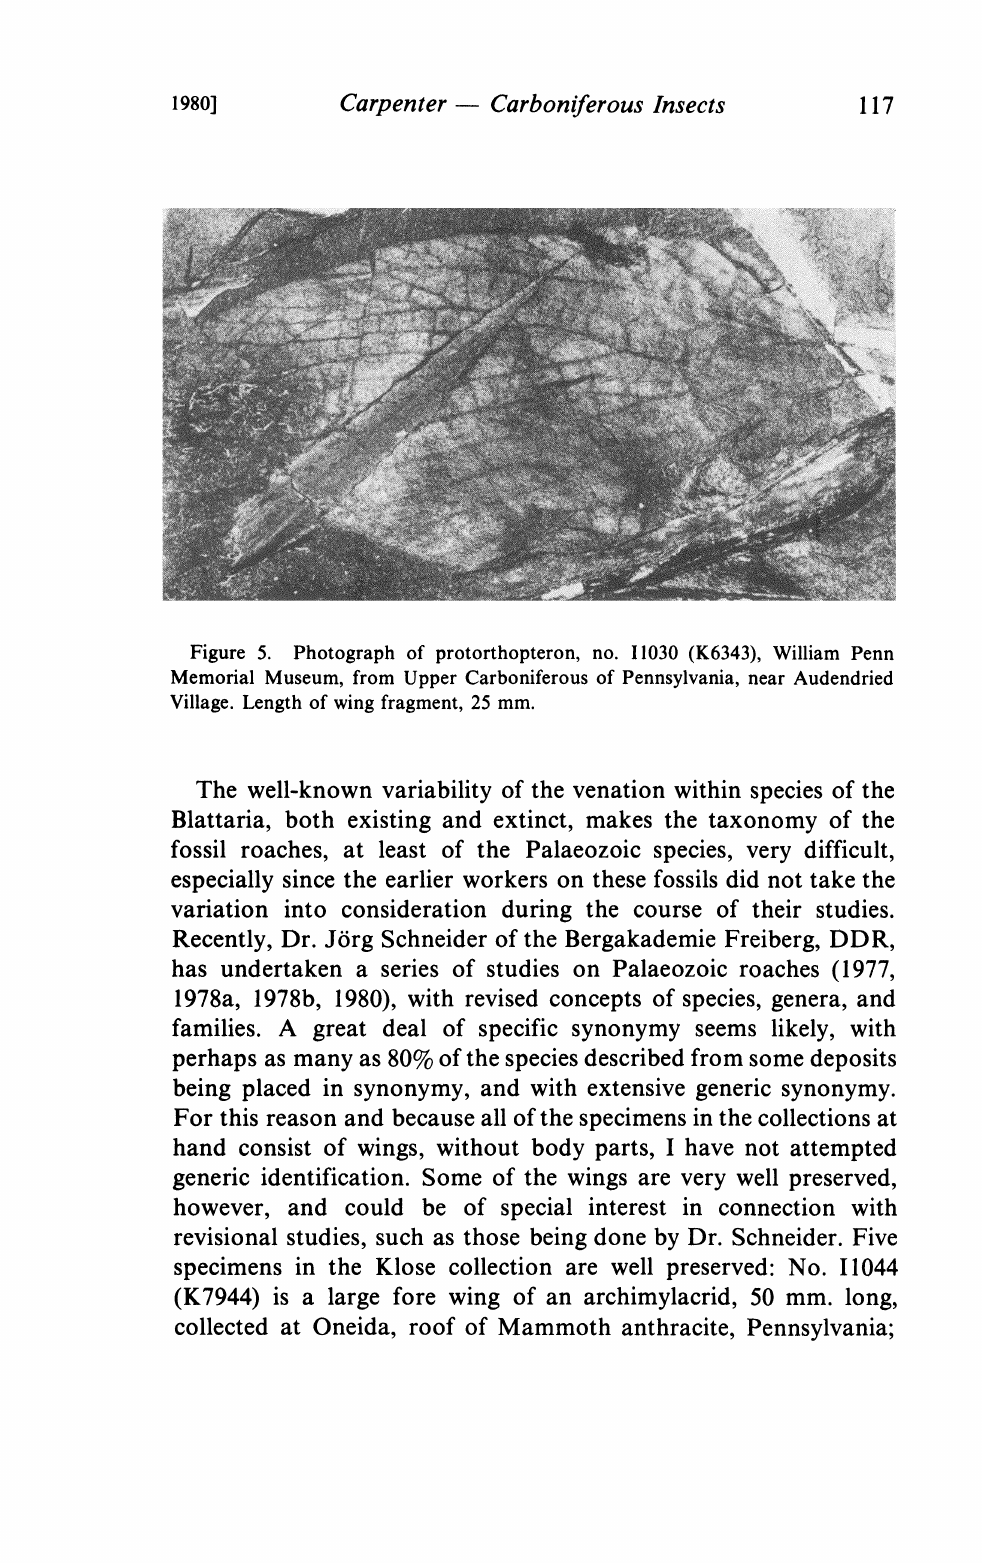
Figure 5. Photograph of protorthopteron, no. 11030 (K6343), William Penn Memorial Museum, from Upper Carboniferous of Pennsylvania, near Audendried Village. Length of wing fragment, 25